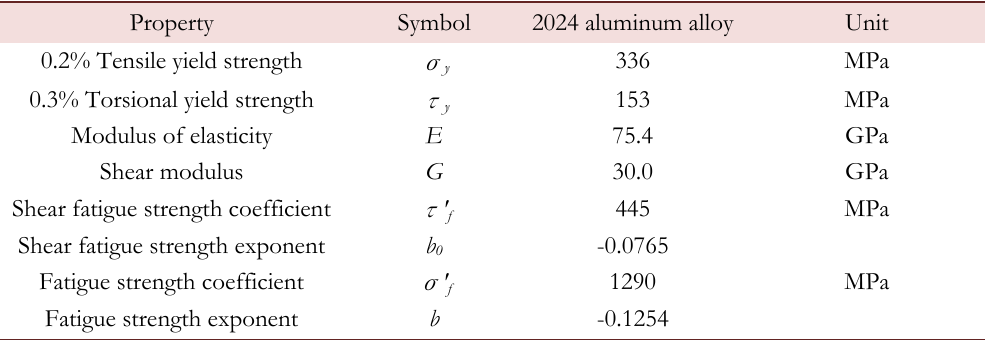
Table 1: Mechanical properties of 2024 aluminum